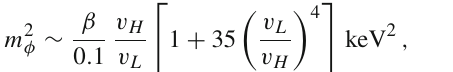
Fig. 1 Majoron parameter space. The left and right vertical axes cor- respond to the majoron-neutrino coupling and the scale at which lep- ton number is spontaneous broken in the type-I seesaw model respec- tively. Current constraints from KamLAND-Zen [89], BBN (see text), and SN1987A [90,91] are shown in grey. The pink region demarcates parameter space for which the majoron fully thermalizes after neutrino decoupling, leading to (cid:5) N eff = 0 . 11. The green band highlights the